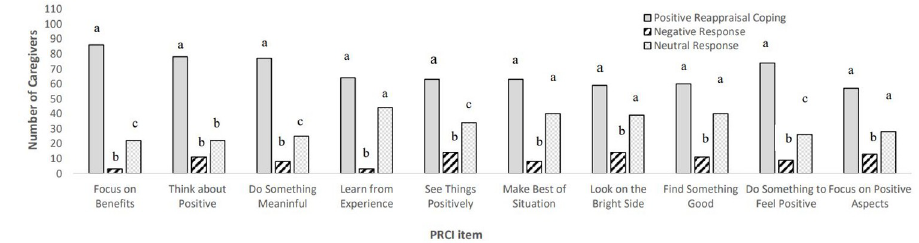
Fig 1. Number of participants providing examples of positive reappraisal coping, negative responses, or neutral responses to PRCI items.